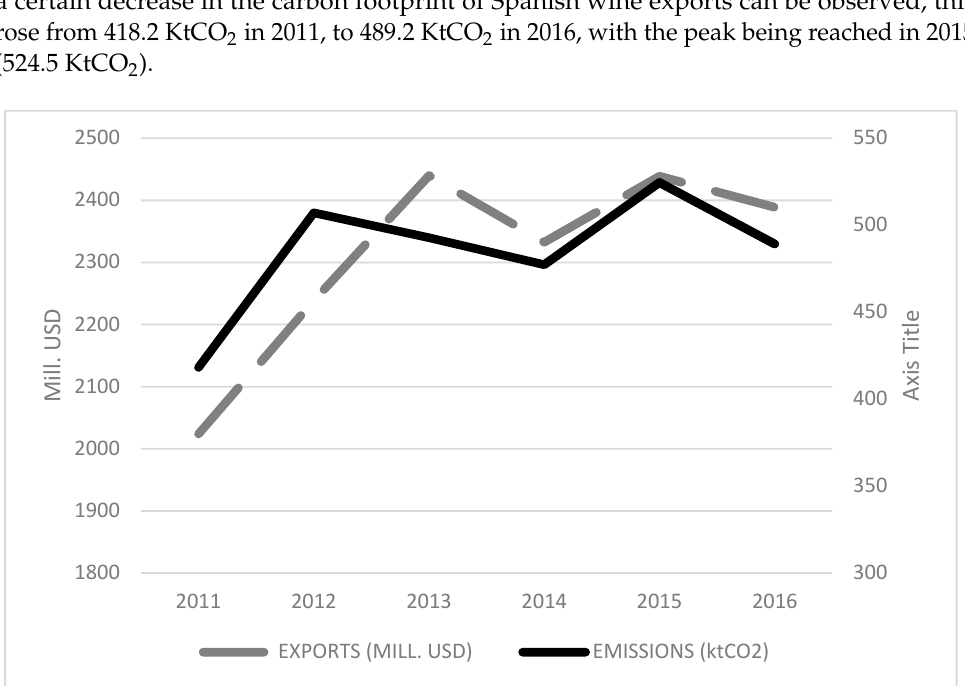
Figure 2. Recent variations in exports (Mill. USD) and emissions (ktCO 2 ), 2011–2016.